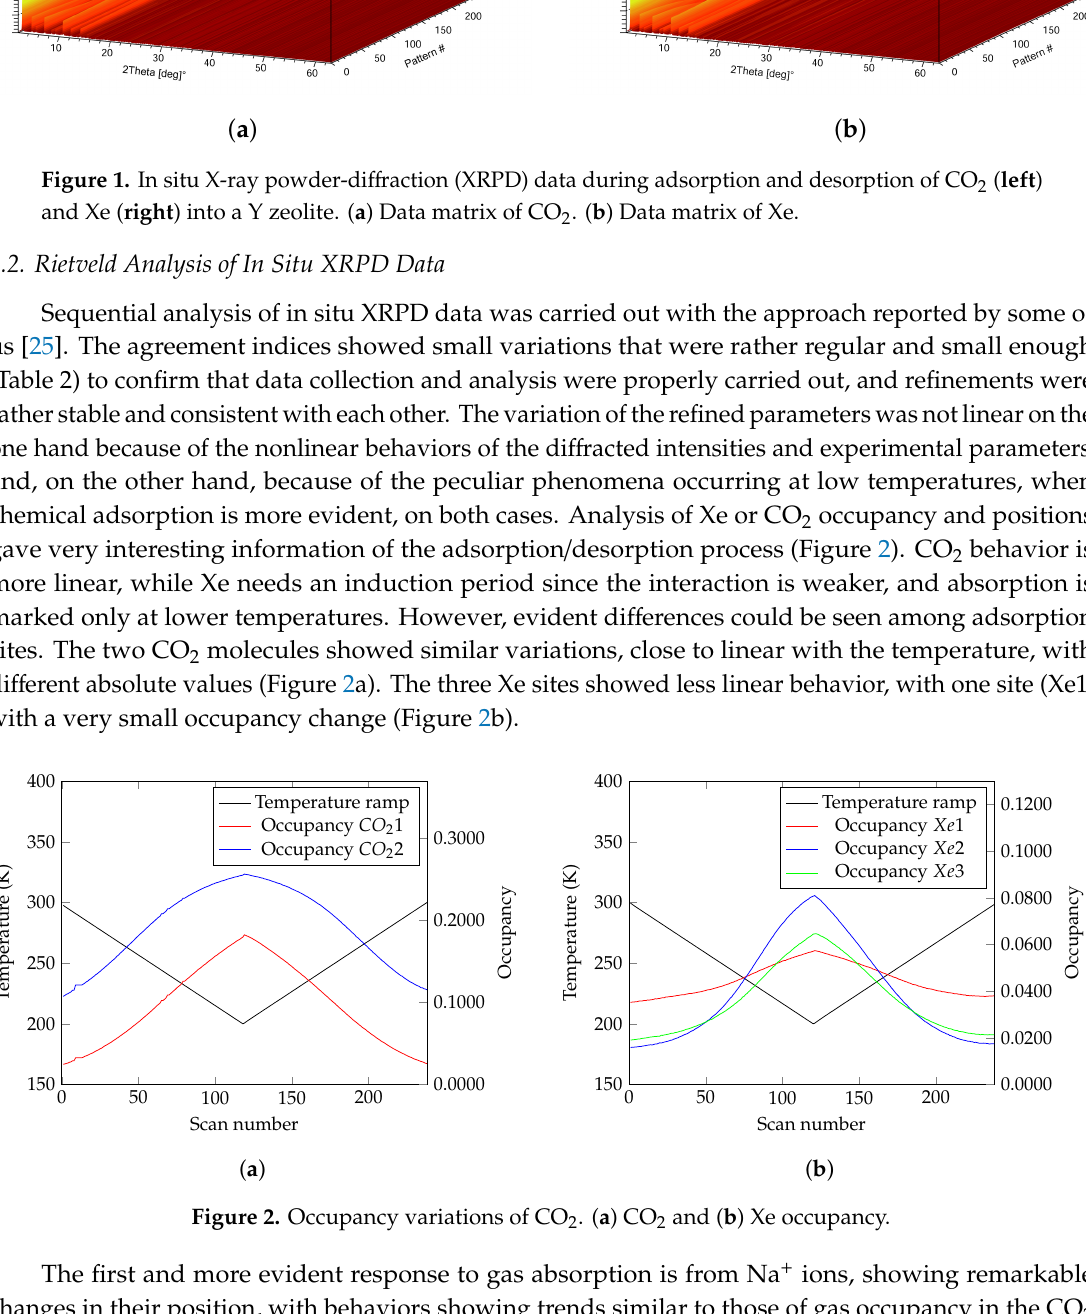
Figure 2. Occupancy variations of CO 2 . ( a ) CO 2 and ( b ) Xe occupancy.